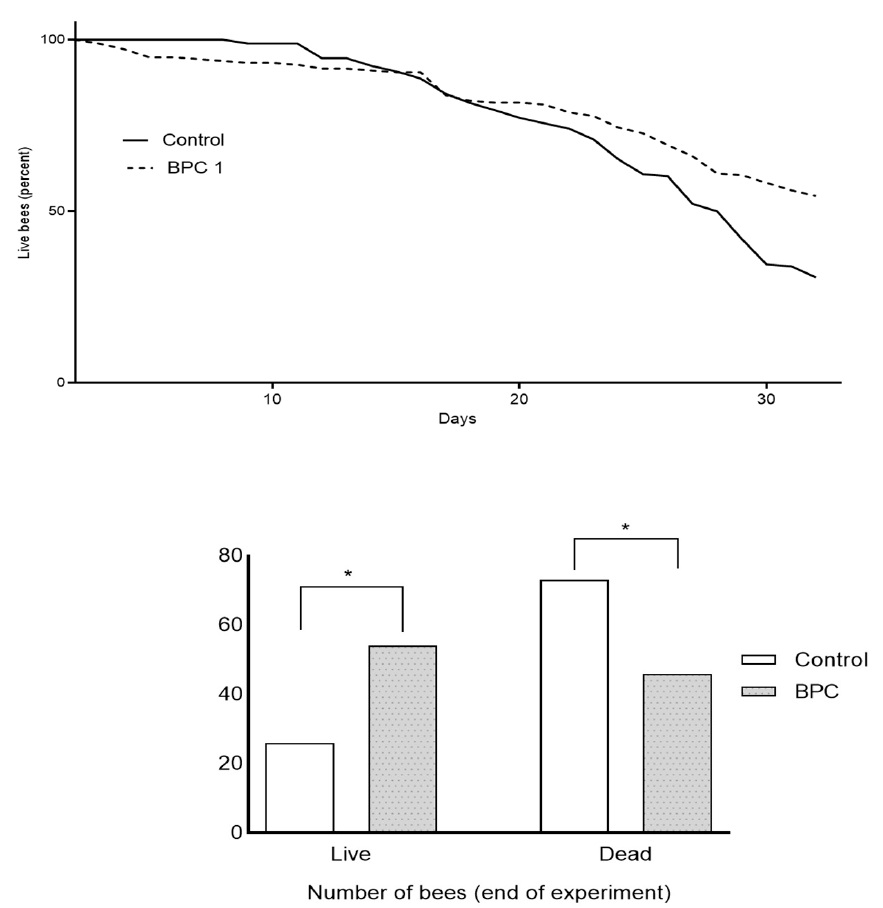
Figure 3. The survival curves of adult honeybees during experiments in laboratory–controlled conditions for the experimental BPC and control group. Asterisks indicate statistically significant differences: BPC vs. control, live/dead adult bees, * p < 0.05.